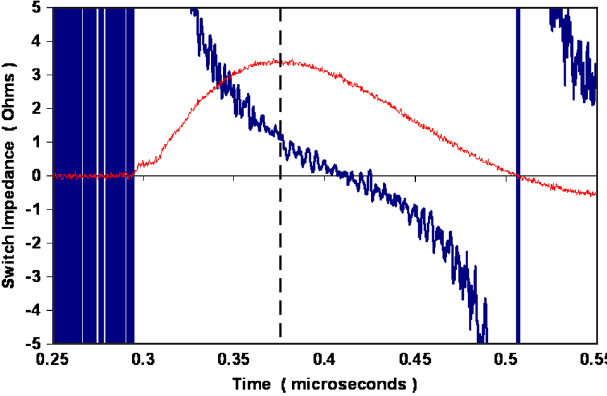
FIG. 21. (Color) Graph of impedance versus time for the Kinetech switch when the brick was charged to (cid:2) 100 kV and discharged into a matched load. Since we have not made any inductive corrections, the graph is only accurate at peak current (indicated by a dashed vertical line), where the graph shows an impedance value of 1.2